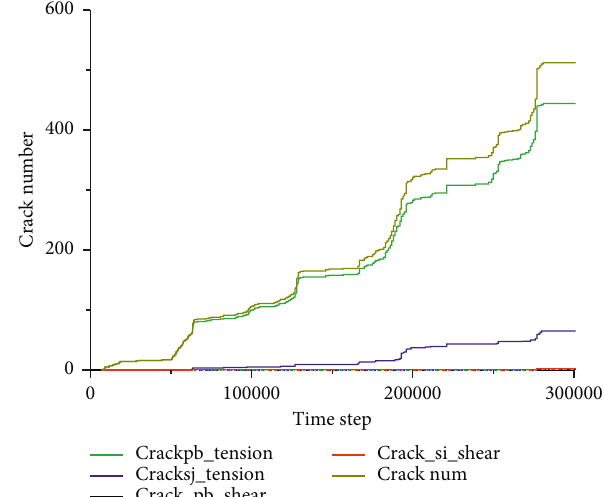
Figure 15: The curve of crack change with time step.